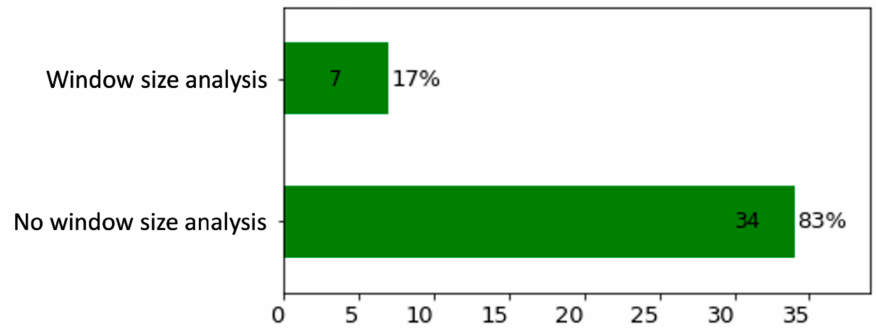
Figure 19. Breakdown of approaches for window size optimisation.